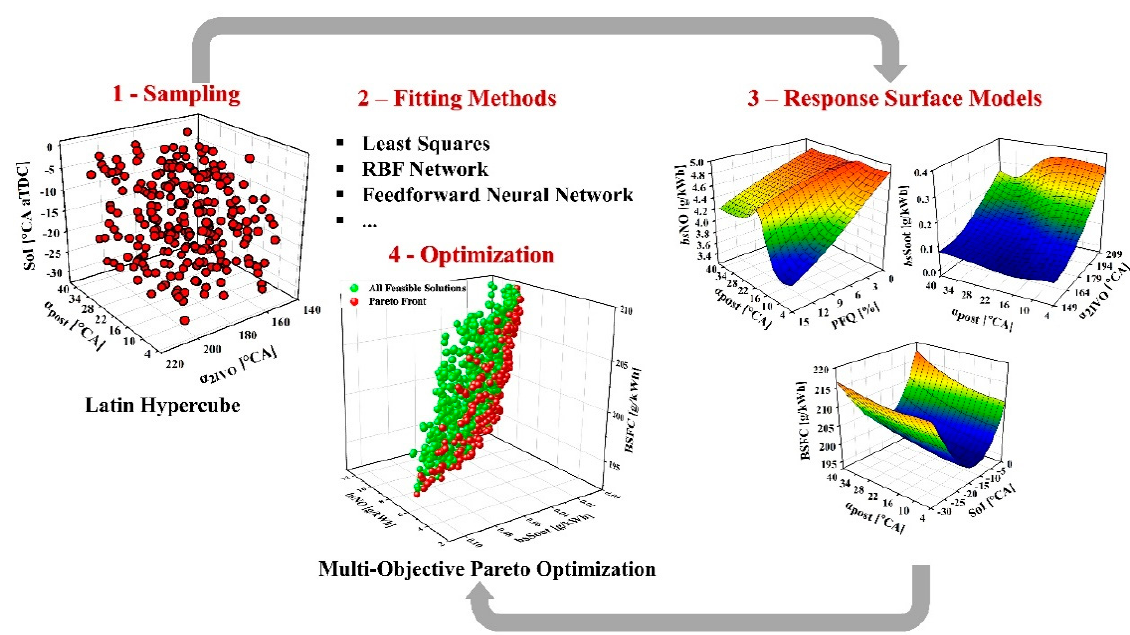
Figure 6. Multi-objective pareto optimization flow chart.